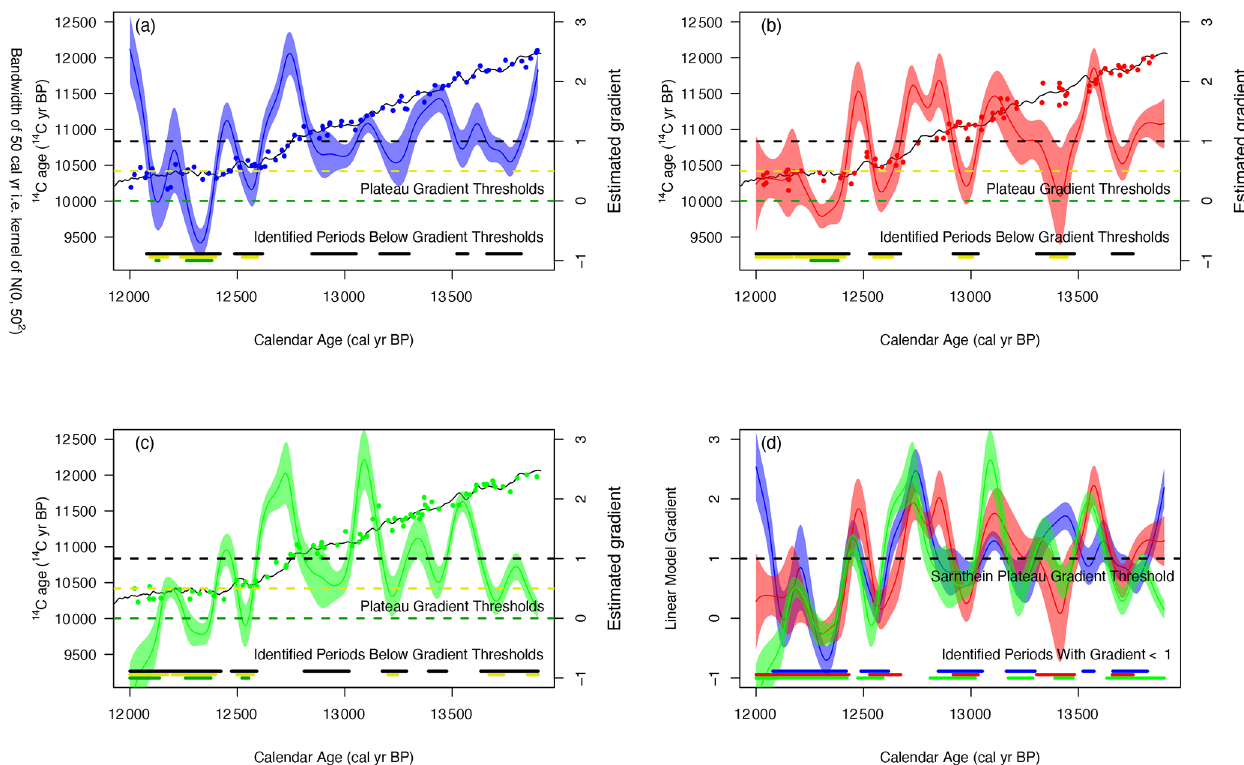
Figure 5. Simulation study to identify the ability of a Suigetsu-style record to reliably identify atmospheric 14 C age plateaus. In panels (a) – (c) we present three simulated atmospheric records generated by sampling, subject to noise, from the high-precision tree-ring-based section of IntCal20 between 12–13.9calkyrBP (shown as a black line) with a sampling density matching that of Lake Suigetsu (Bronk Ramsey et al., 2020). The level of noise added to create the simulated 14 C observations (blue, red, and green dots) is of an equivalent level to that present in Lake Suigetsu 14 C. For each simulated set of observations, we present an estimate of the local gradient (shown as blue, red, and green curves with their 95% confidence intervals) according to a locally weighted linear model as proposed by Sarnthein et al. (2015). These local gradient estimates are obtained using a N (0 , 50 2 calyr 2 ) kernel to provide the weightings. We overlay three gradient thresholds (0, 0.5, and 1 14 Cyr(calyr) − 1 ) that might be used to identify a 14 C age plateau. Shown as a rug at the bottom of each plot are the time periods in each core that correspond to a local gradient below each threshold (color coded by threshold). In panel (d) we overlay the gradient estimates to assess consistency (or lack of) between the three simulated cores in terms of the number and location of 14 C age plateaus one might identify. As a rug, we plot the time periods in each core (color coded by core) that correspond to a local gradient below the threshold of 1 14 Cyr(calyr) − 1 proposed by Sarnthein et al.